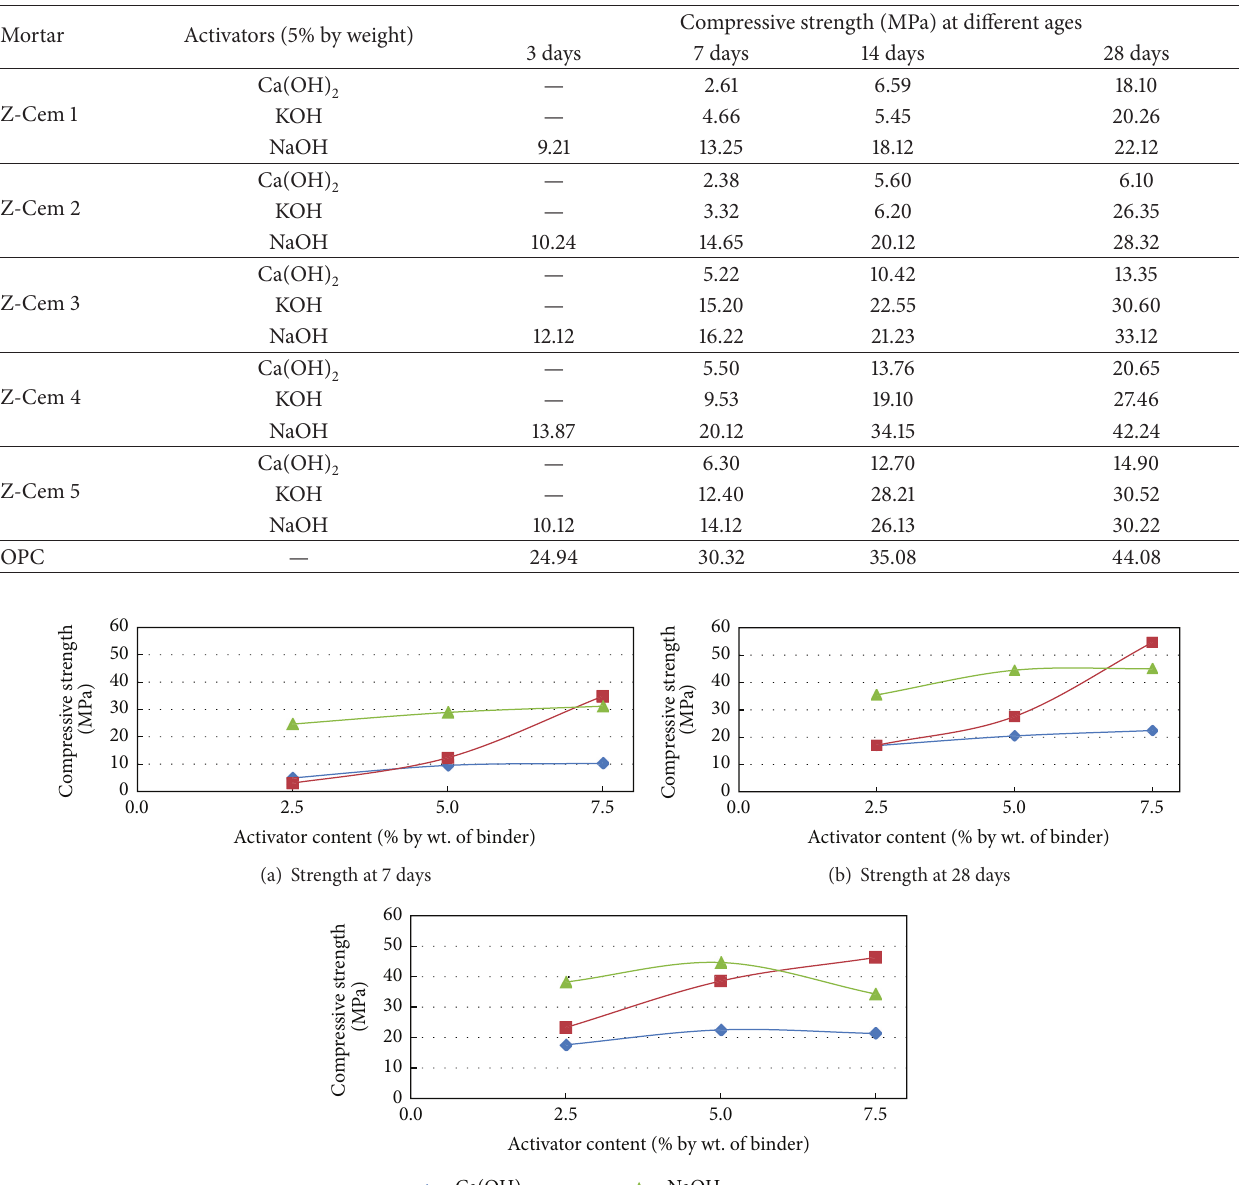
Table 7: Strength of mortar as influenced by types of activators.